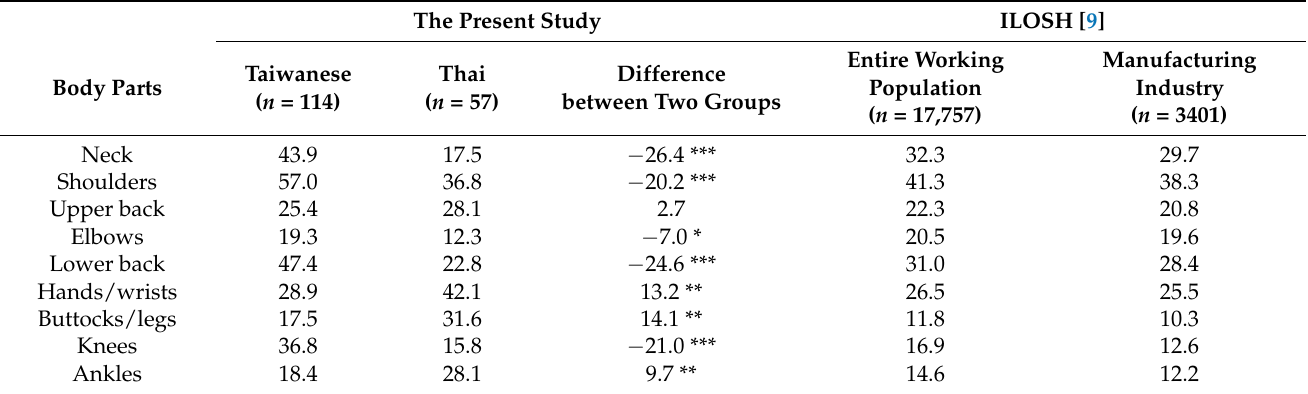
Table 3. Prevalence of musculoskeletal discomfort in various body parts of Taiwanese and Thai manufacturing industry workers and of workers in other industries (unit: